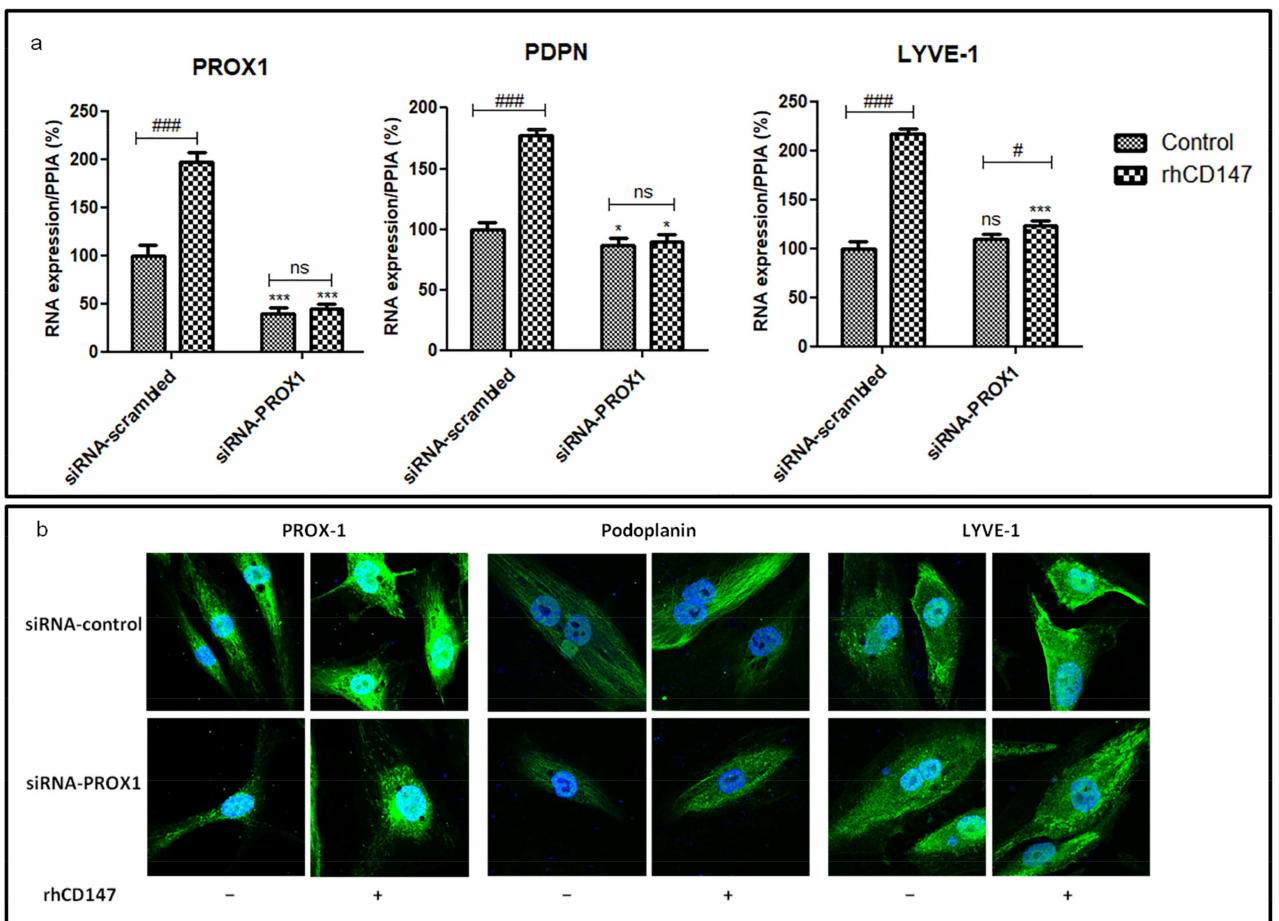
Figure 4. CD147 regulates LECs lymphangiogenic markers through PROX-1 transcription factor. LECs were transfected with scrambled or PROX-1 siRNA and treated or not with rhCD147. ( a ) qRT-PCR of PROX1 , PDPN , and LYVE1 expression using PPIA as a reference. Columns indicate means of three independent experiments carried out in triplicate; bars indicate SD; * p < 0.05, *** p < 0.0001 for siRNA-PROX-1 vs. siRNA-scrambled. ns, nonsignificant, # p < 0.05, ### p < 0.0001 for treated vs. untreated cells. ( b ) Representative confocal images of immunofluorescence staining for PROX-1, Podoplanin and LYVE-1 (63 ×